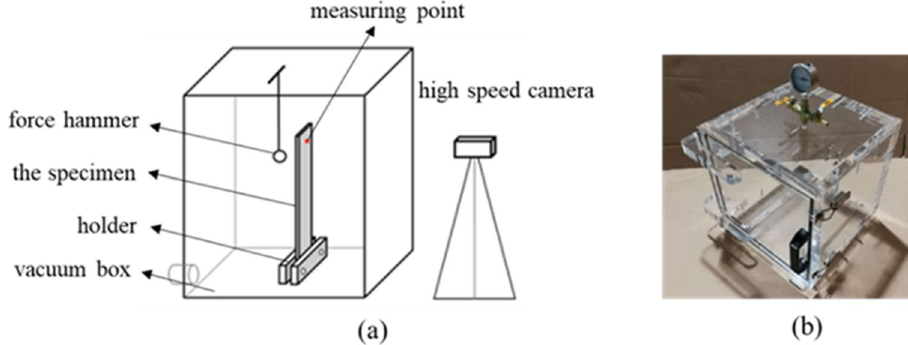
Figure 2. The specimen damping test system. ( a ) Glass vacuum box—schematic diagram of vacuum non- contact damping test equipment. ( b ) High-speed camera acquisition systemspeed—physical drawing of vacuum